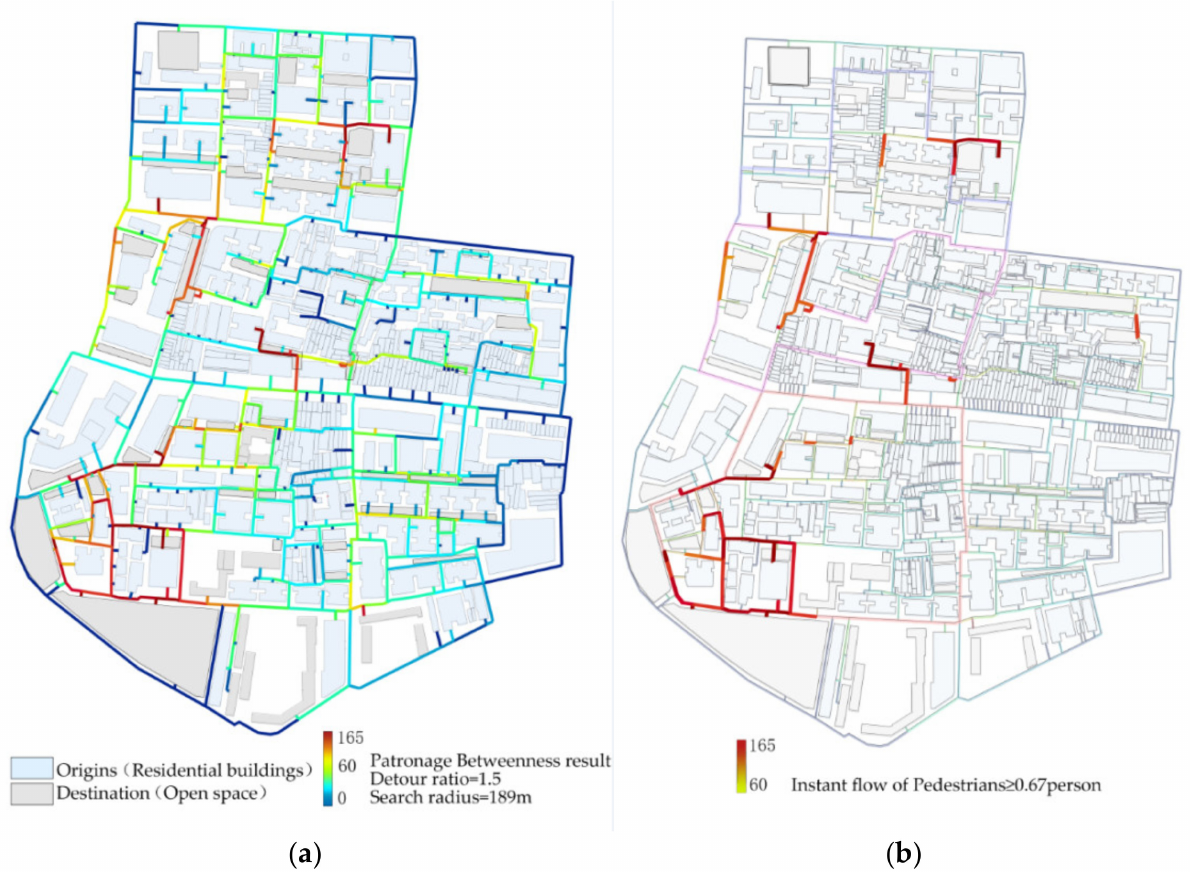
Figure 11. ( a ) Pedestrian flow rates of the children; ( b ) crowded pedestrian route for the